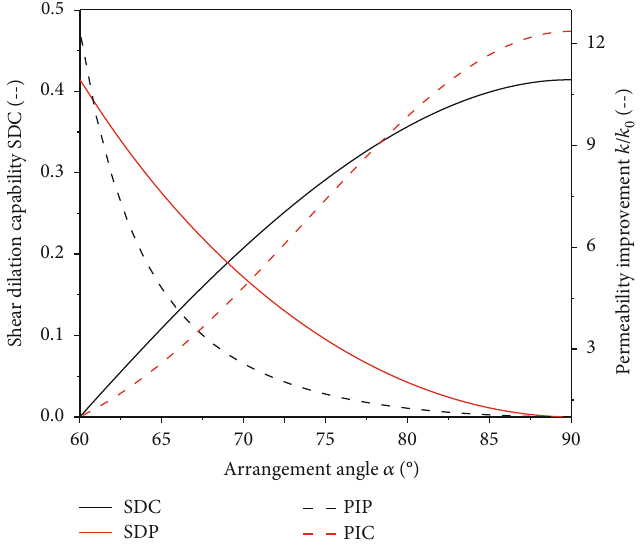
Figure 10: 3D evolutions of the shear dilation and permeability improvement capability/potential.